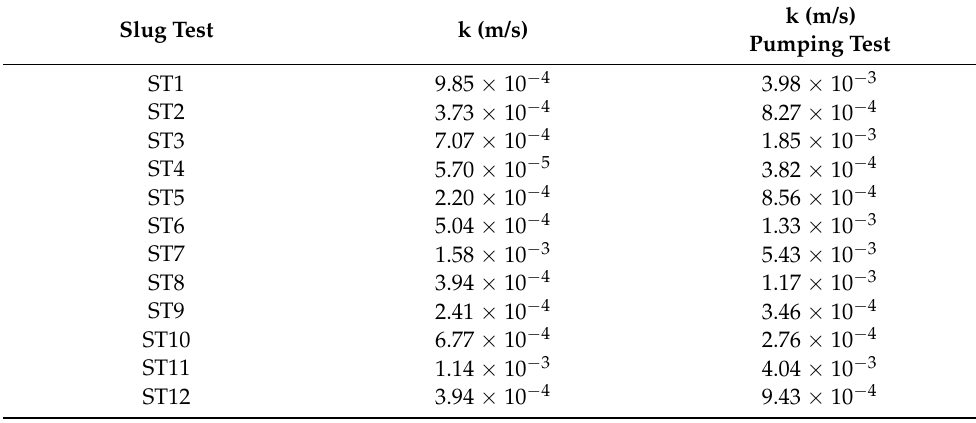
Table 1. K-values obtained using slug test and pumping test data in correspondence to the same